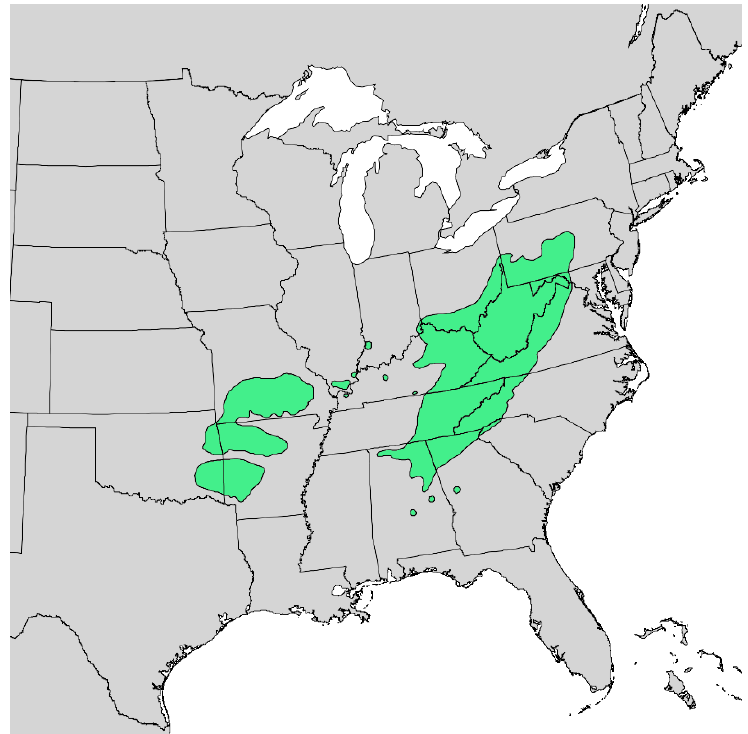
Figure 5. Robinia pseudoacacia L. distribution map [123]. https://commons.wikimedia.org/w/index.php?curid=29169867